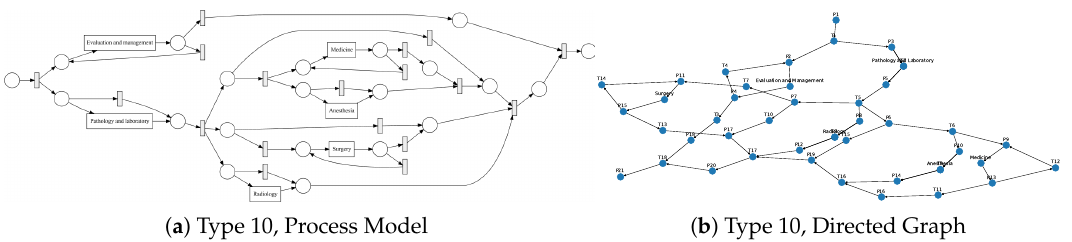
Figure 5. Process model (left) and constructed directed graph (right) for cancer type 10. Graph on the right was drawn using the networkx implementation of Kamada-Kawai path-length cost-function. Note that there is node and edge overlap for all event nodes, making the position nodes hardly visible.